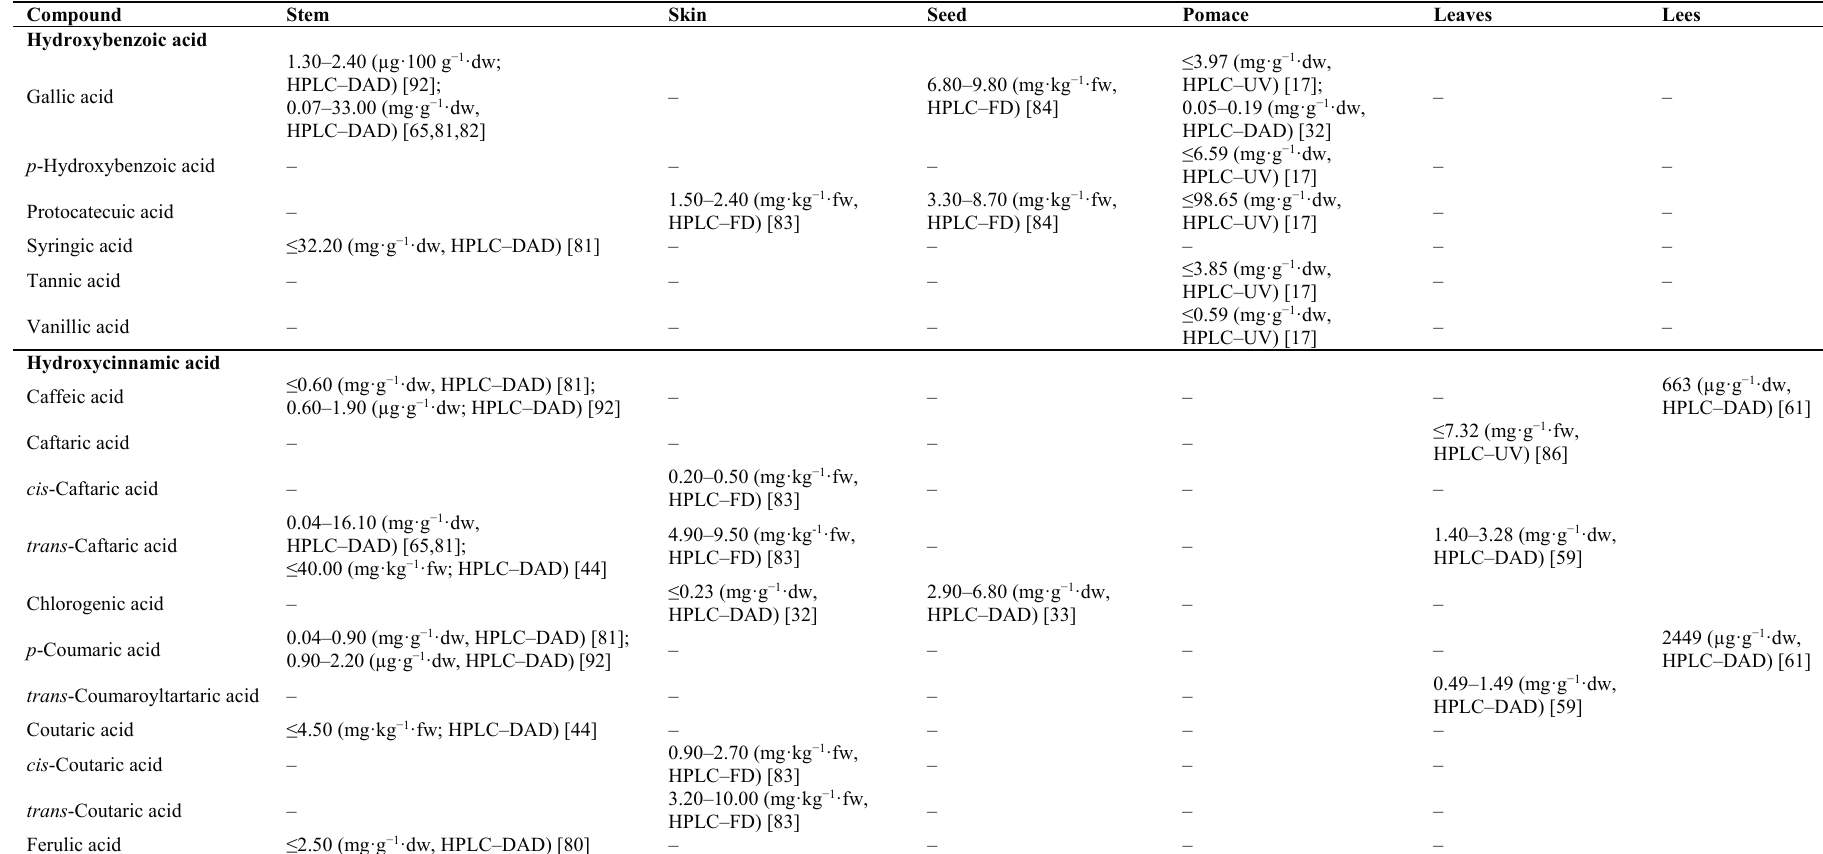
Table 1. Content in phenolic acids (analytical technique employed) in winery residues from different red varieties of Vitis vinifera L.